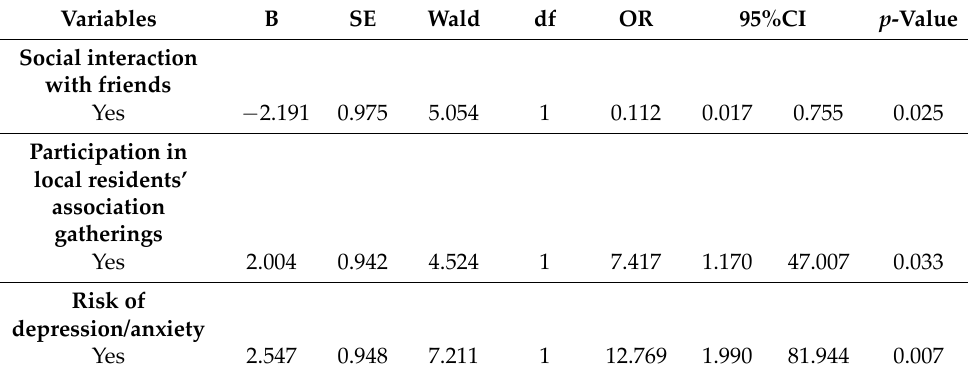
Table 4. Results of binomial logistic regression analysis ( n =